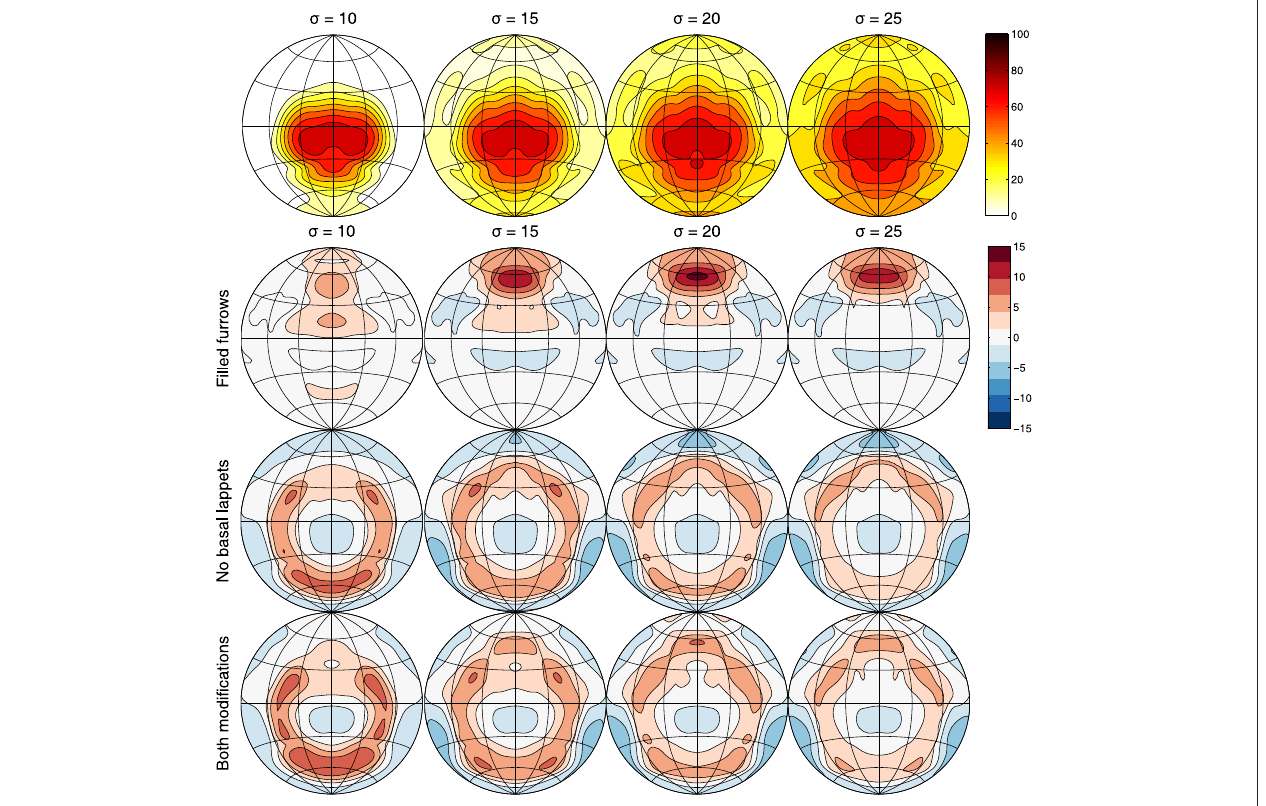
FIGURE 4 | Row 1: The probability of the energy of an FM echo coming from a clutter object being higher than an echo coming from the target position as a function of azimuth and elevation (Contours spaced 10% apart) and for different values of σ . As specified in the main text, the reflector strength of objects in the environment is assumed to be normally distributed. The